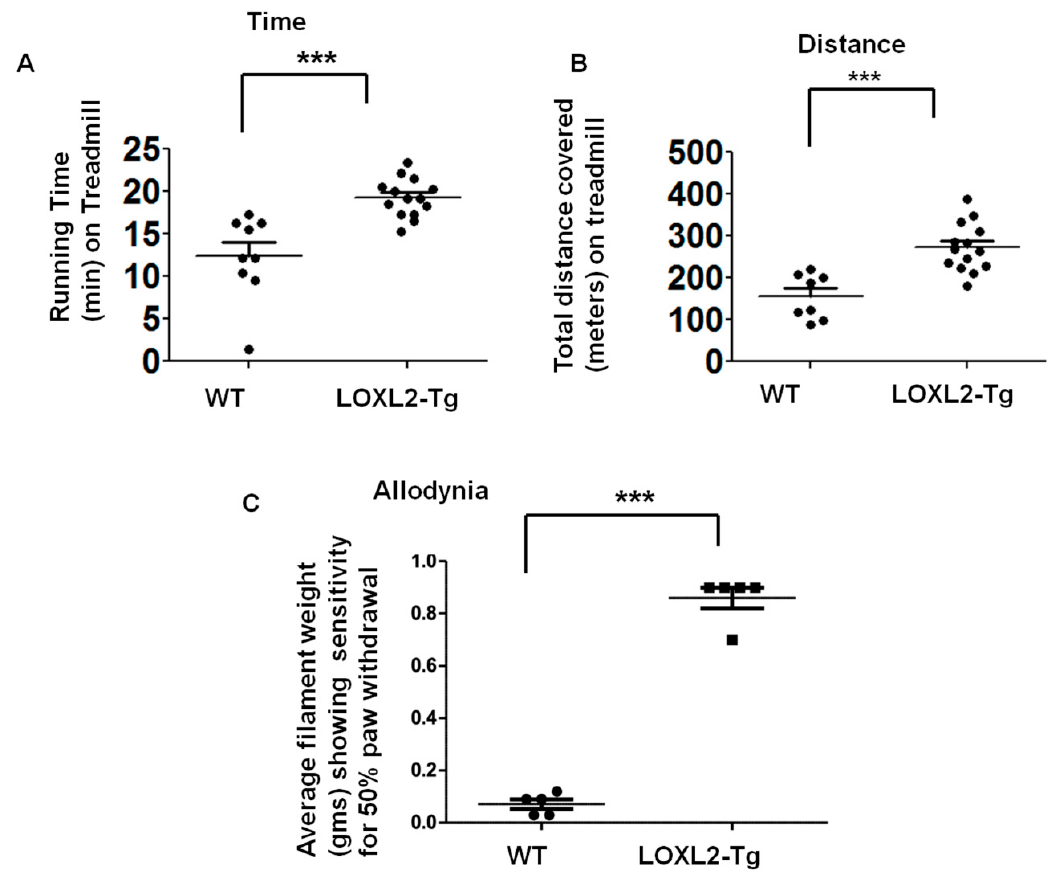
Figure 6. LOXL2 overexpression in transgenic mice protects against MIA-induced OA-related decline in knee joint function. ( A ) Maximal time spent on the treadmill by MIA-induced LOXL2 transgenic and WT mice. ( B ) Total distance covered on the treadmill by MIA-induced LOXL2 transgenic and WT mice. ( C ) Quantification of average Von Frey hairs weight (gms) (as indicated in the graph, y -axis), showing pain-sensitive allodynia of MIA-induced LOXL2 transgenic (square) and WT mice (dot). The statistically significant differences were evaluated by one-way ANOVA with Bonferroni correction (*** p < 0.001; ANOVA).